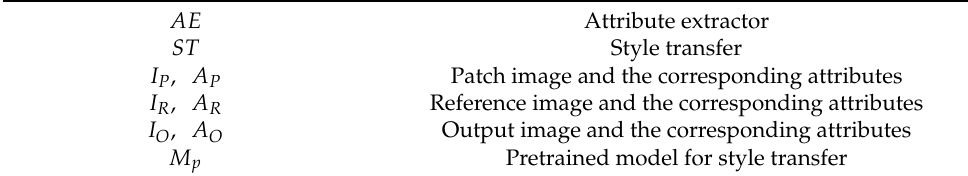
Table 1. Major notations.